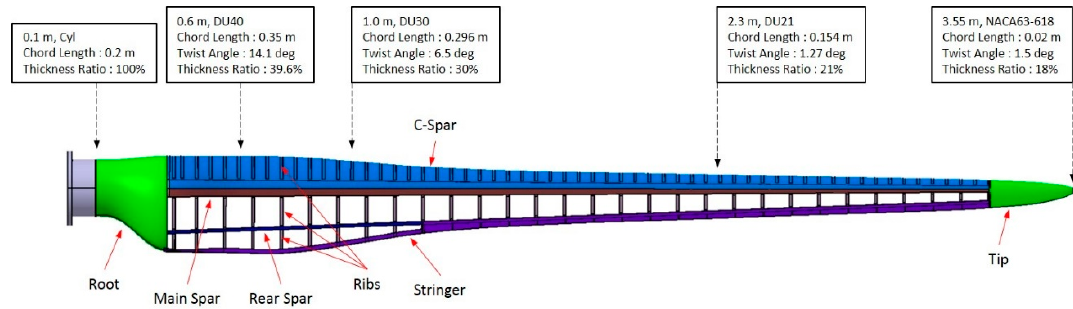
Figure 3. The fabric-covered blade structure.